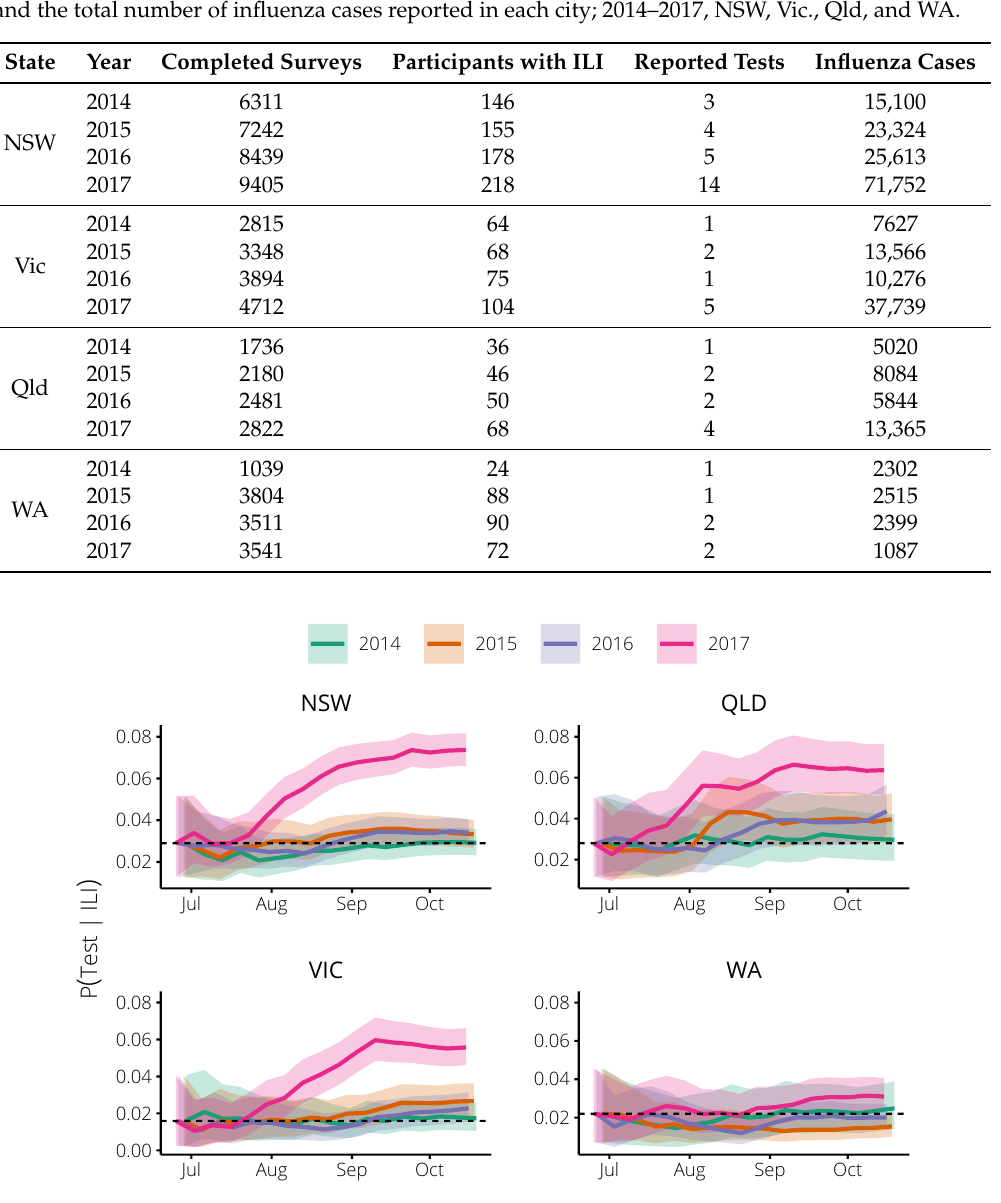
Figure 1. The probability of being swabbed for an influenza test, given ILI symptoms, as estimated from the weekly Flutracking survey data in each of the 2014–2017 seasons for participants in: New South Wales ( top-left ); Queensland ( top-right ); Victoria ( bottom-left ); and Western Australia ( bottom-right ). The horizontal dashed lines indicate the prior expectation for each state, the solid lines indicate the posterior expectation, after applying our statistical model, and the shaded regions indicate the 95% median-centred credible interval. In all states except Western Australia, this probability was much higher in 2017 than in previous years. Queensland also exhibited a moderate increase in